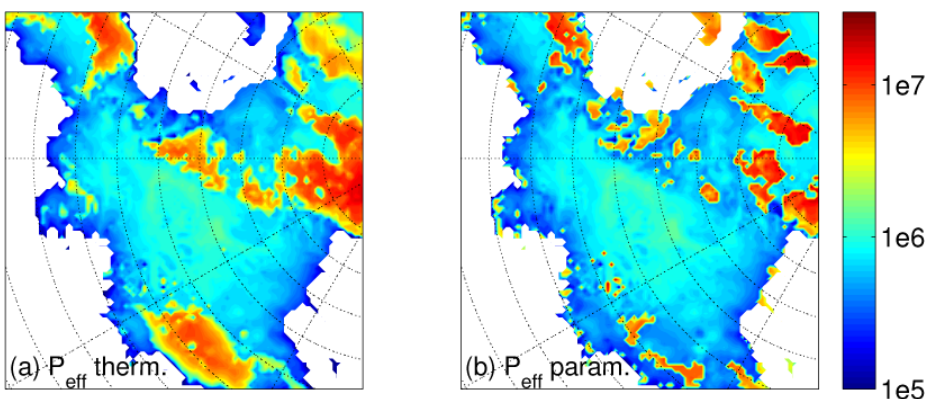
Fig. 4. Effective pressure with pore water pressure according to Eq. (11) with (a) λ thermodynamically computed as in Bueler and Brown (2009) and (b) parameterized according to Eq. (12).